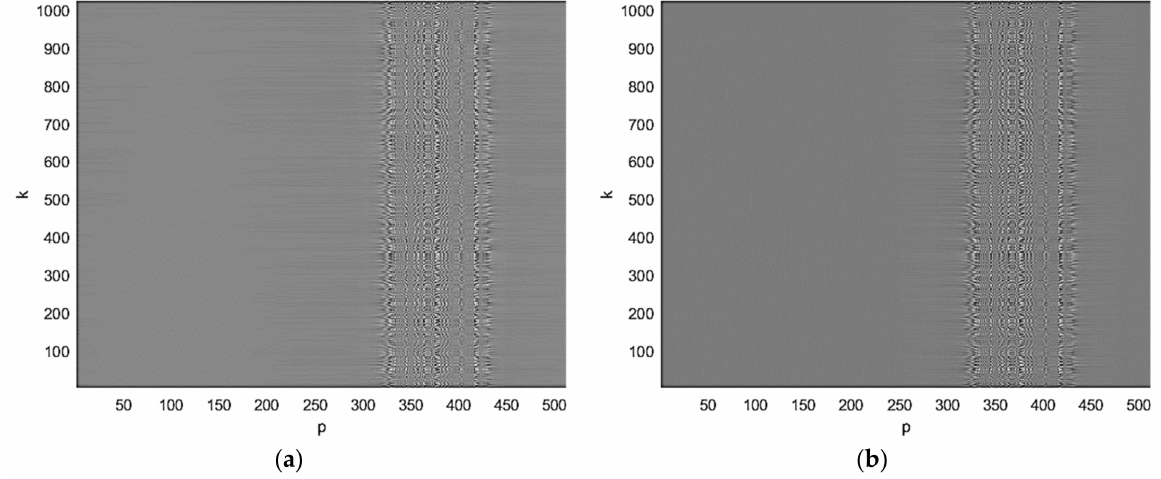
Figure 4. BFISAR signal after range compression: ( a ) real and ( b ) imaginary